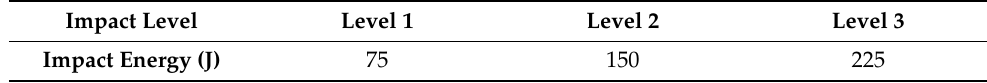
Table 2. Impact energy levels used in the study.